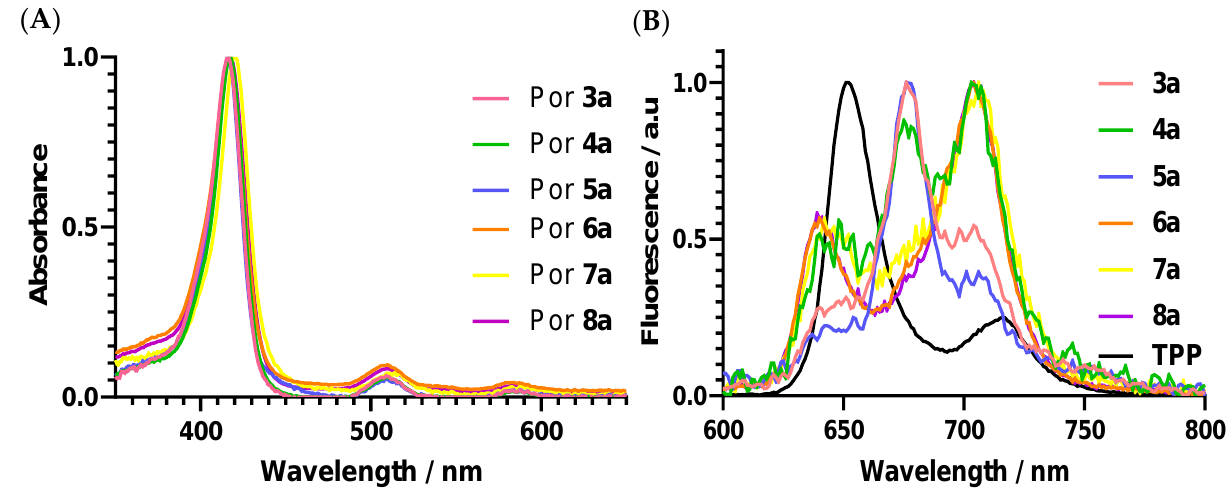
Figure 1. Normalized ( A ) absorption and ( B ) emission spectra of Pors 3a – 8a in DMSO at 298 K. The 1 H NMR spectrum of the Por 1 is characteristic of a trisubstituted pattern, evidencing two doublets at δ 6.55 ppm and δ 8.23 ppm ( J = 7.7 Hz) corresponding to the resonance of 6 meta -protons and 6 ortho -protons on the 4-pyridinone groups, respectively. Additionally, the 19 F NMR spectrum of Por 1 is compatible with a para substitution pattern of three pentafluorophenyl rings and one unsubstituted pentafluorophenyl ring. The 19 F NMR spectra of Pors 3 – 5 revealed the disappearance of the signal at − 149.75 ppm due to the para -fluorine replacement by the cyclodextrin and the appearance of two multiplets on the interval of δ − 146.92– − 144.68 ppm and δ − 135.72– − 133.69 ppm, corresponding these signals to the ortho - and meta -fluorine atoms. The cationization of the neutral compounds provided to the Pors 3a – 5a were confirmed by the appearance of the singlet in the aliphatic region located at δ 4.36–4.37 ppm of the 1 H NMR, which corresponds to the resonance of the -OCH 3 protons.